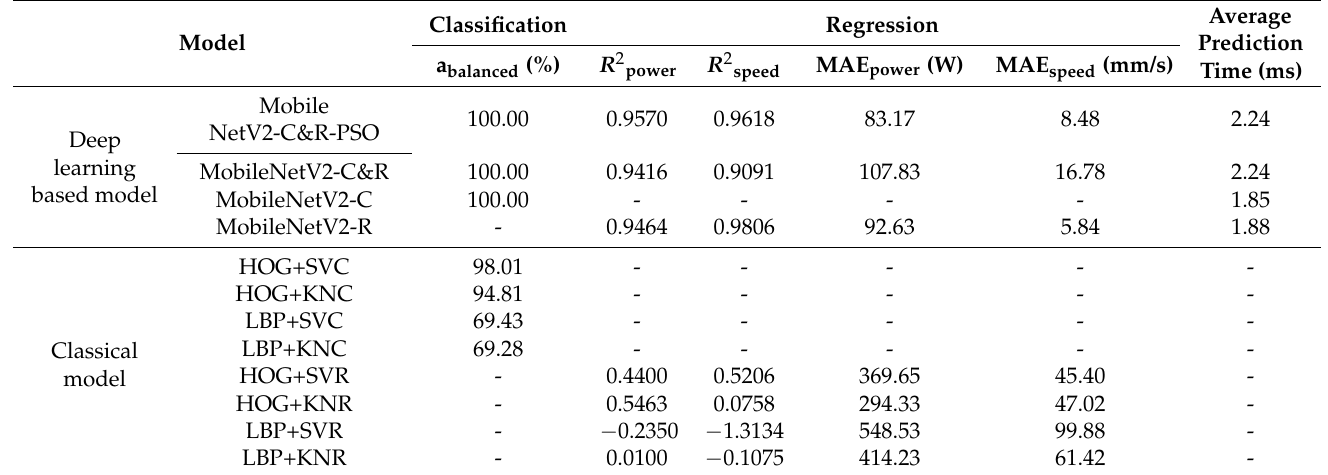
Table 1. Performance of different models on the test